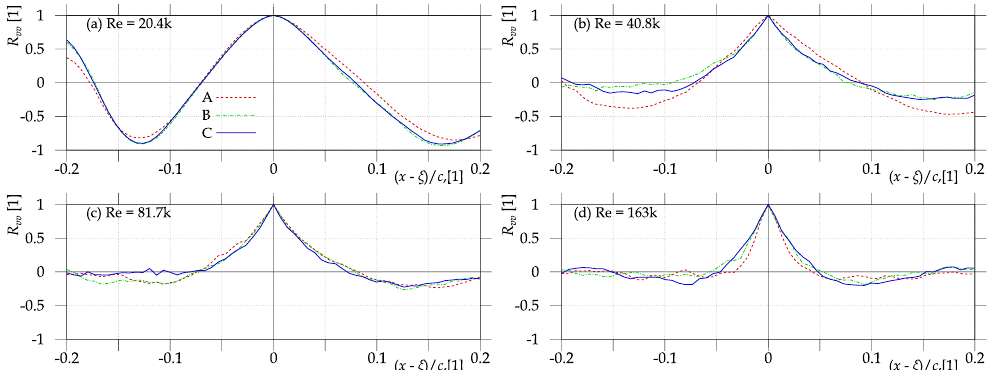
Figure 18. The stream-wise profile of the autocorrelation function of the cross-stream velocity component at α = 0 ◦